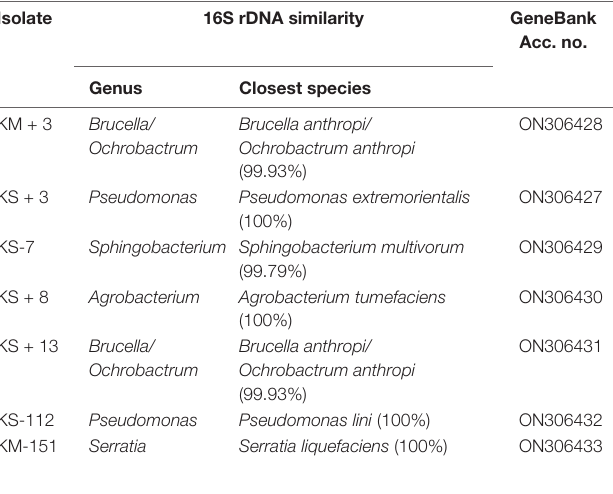
Isolate 16S rDNA similarity GeneBank